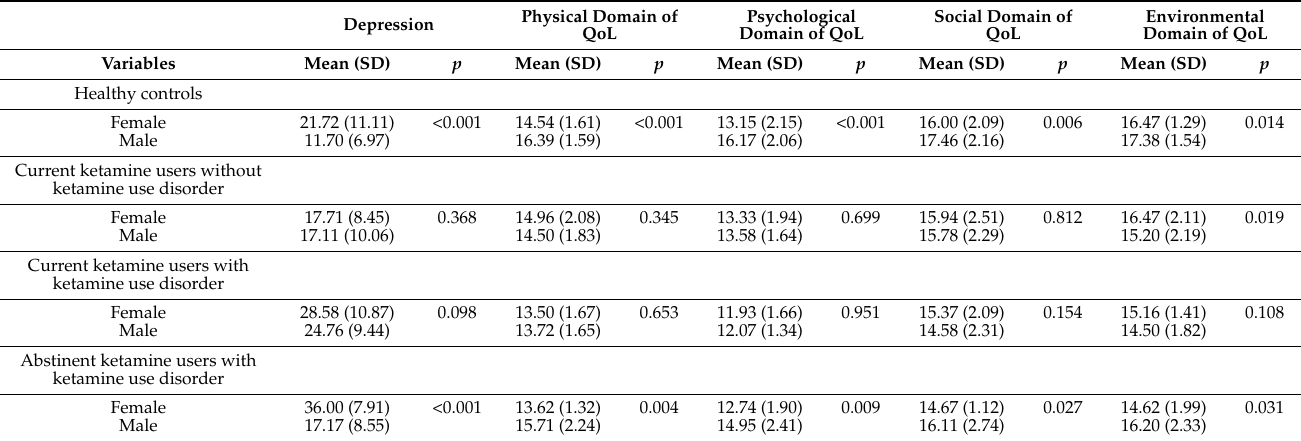
Table 2. Gender differences in the severity of depression and quality of life (QoL) among healthy controls and ketamine- related